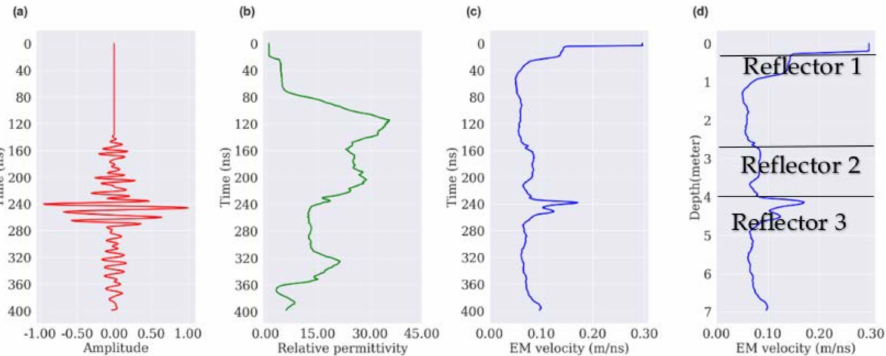
Figure 16. ( a ) GPR trace at 13.32m offset in time depth domain, ( b ) the variation of ε r in the time domain, ( c ) EM velocity in the time domain, and ( d ) EM velocity in the depth